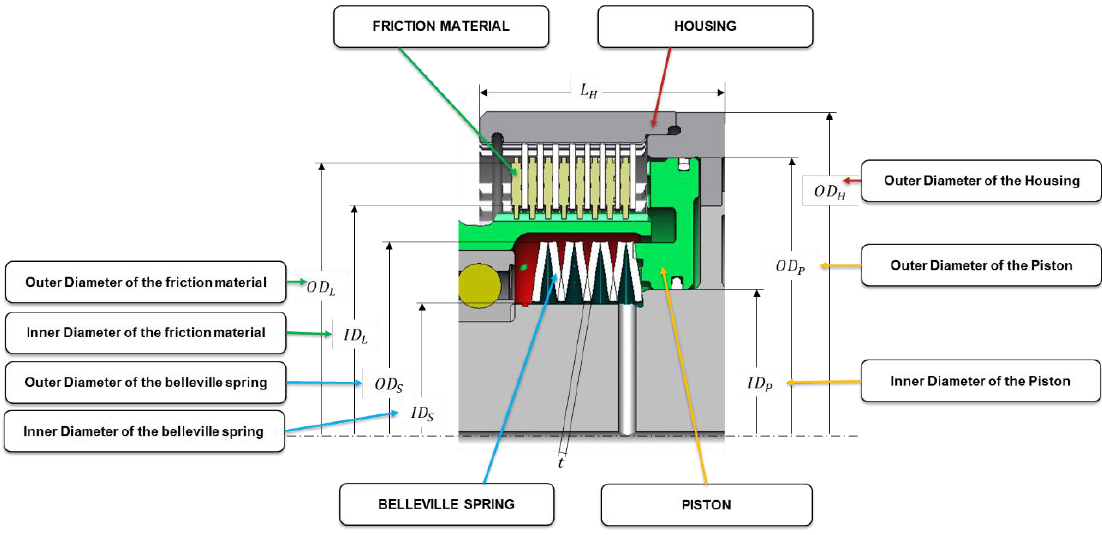
Figure 7. CAD model of the clutch produced on the basis of the DA datasheet.